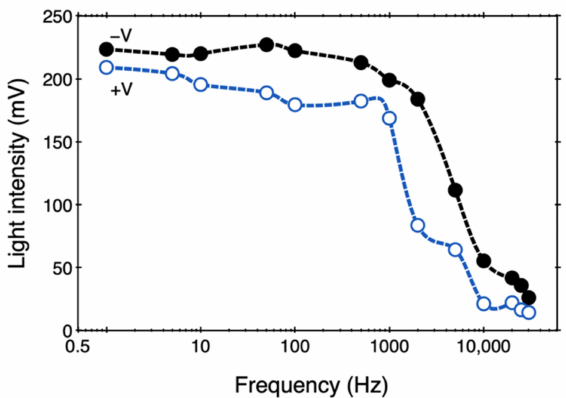
Figure 7. The di ff erence between the transmitting light intensities of the 10- µ m TFS-BPIII cell in the positive and negative polarities of the applied field when the frequency is tuned from 1 Hz to 10 kHz.